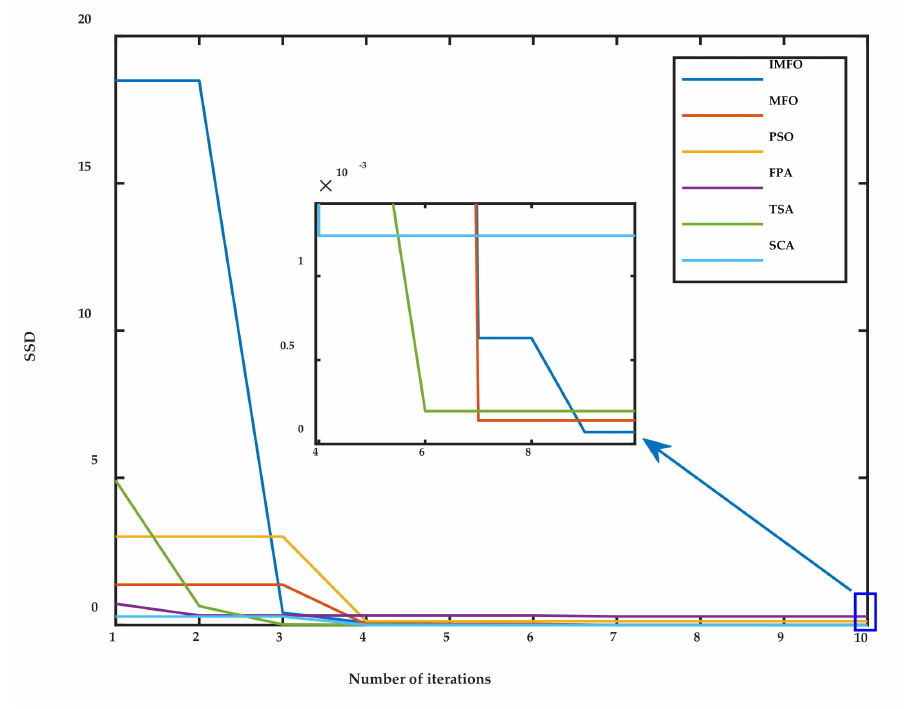
Figure 6. Convergence curves of IMFO and other comparative metaheuristic algorithms.